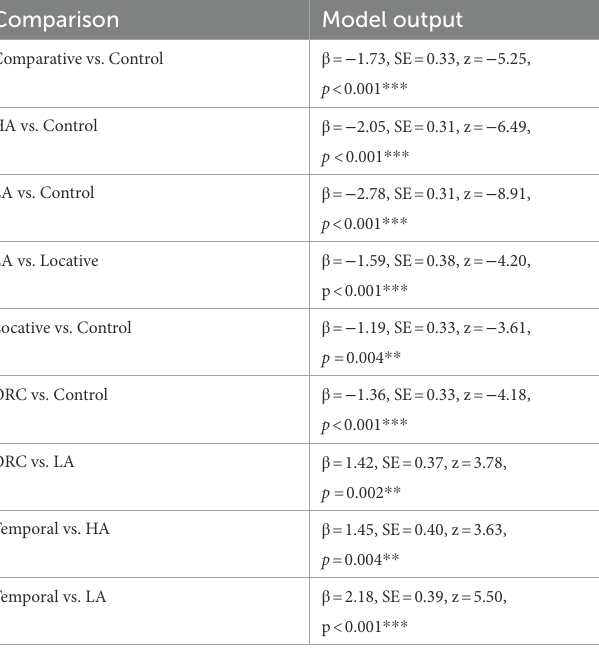
TABLE 4 Significant model outputs for accuracy analysis in Experiment 1.